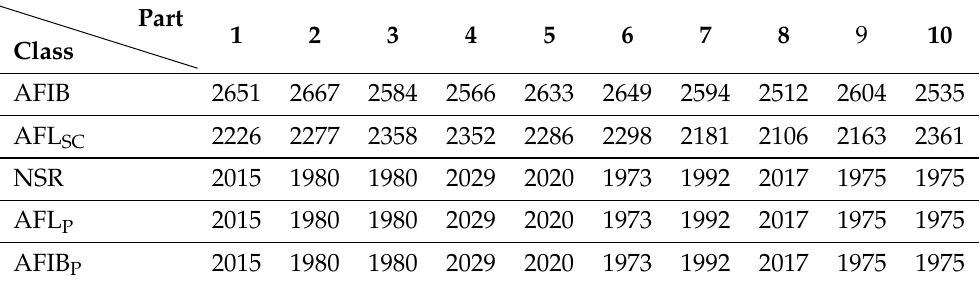
Table 3. The number of data vectors per signal class in each part. AFL P and AFIB P denote the punctured datasets for NSR and AFIB,